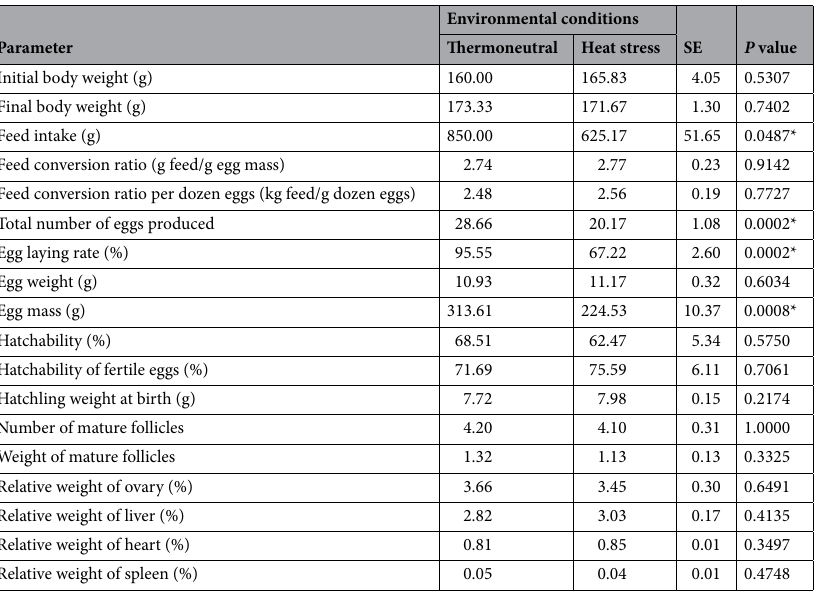
Table 1. Performance of the mothers. Female quail hens ( n = 40) were divided and subjected to two environmental conditions: thermoneutral (23 °C and 60% relative humidity) ( n = 10) and heat stress (continuous exposure to 32 °C and 60% relative humidity) ( n = 30). SE standard error. An asterisk (*) indicates a significant difference by the t test ( P <